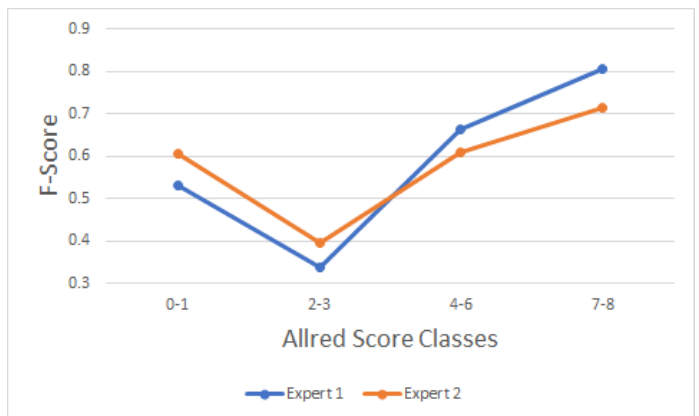
Figure 4. F-Score obtained with Wnt-1 automatic classification using Expert-1 and Expert-2’s Allred score. [0–1] represents no affect, [2–3] represents small, [4–6] represents moderate, and [7–8] represents good. The y-axis is not displayed from the origin to improve visualization.